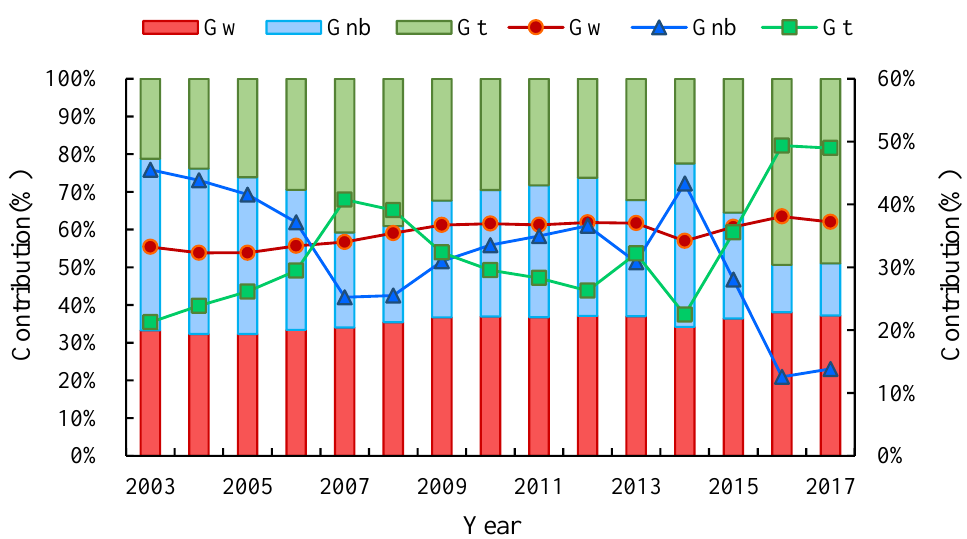
Figure 7. The sources of the differences in CEE and the trends of their contributions.